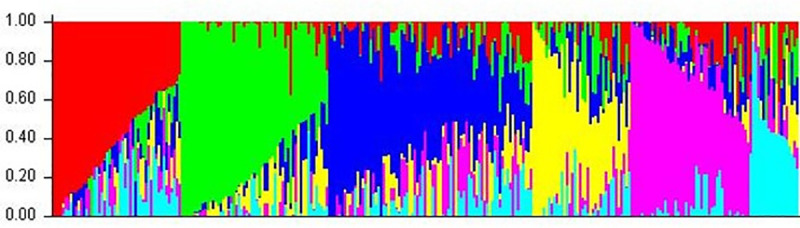
Linkage disequilibrium plot of significant marker associations.R2 and P-values of pair-wise analyses are indicated by colour in the right-side bars.